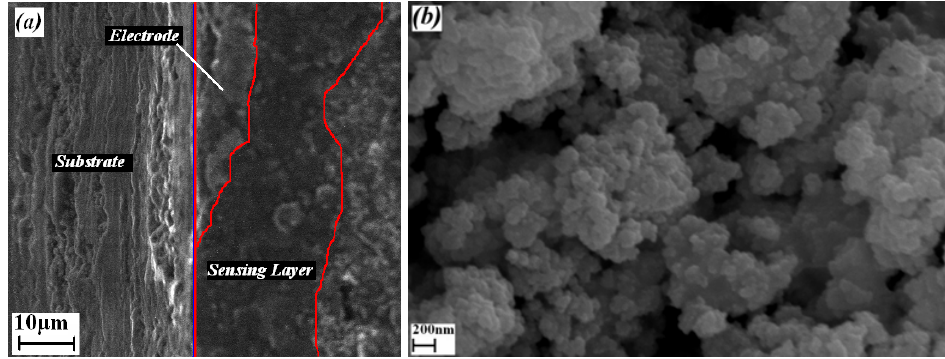
Figure 7. SEM micrographs: (a) cross-section of sensor layer, (b) surface of sensing film.